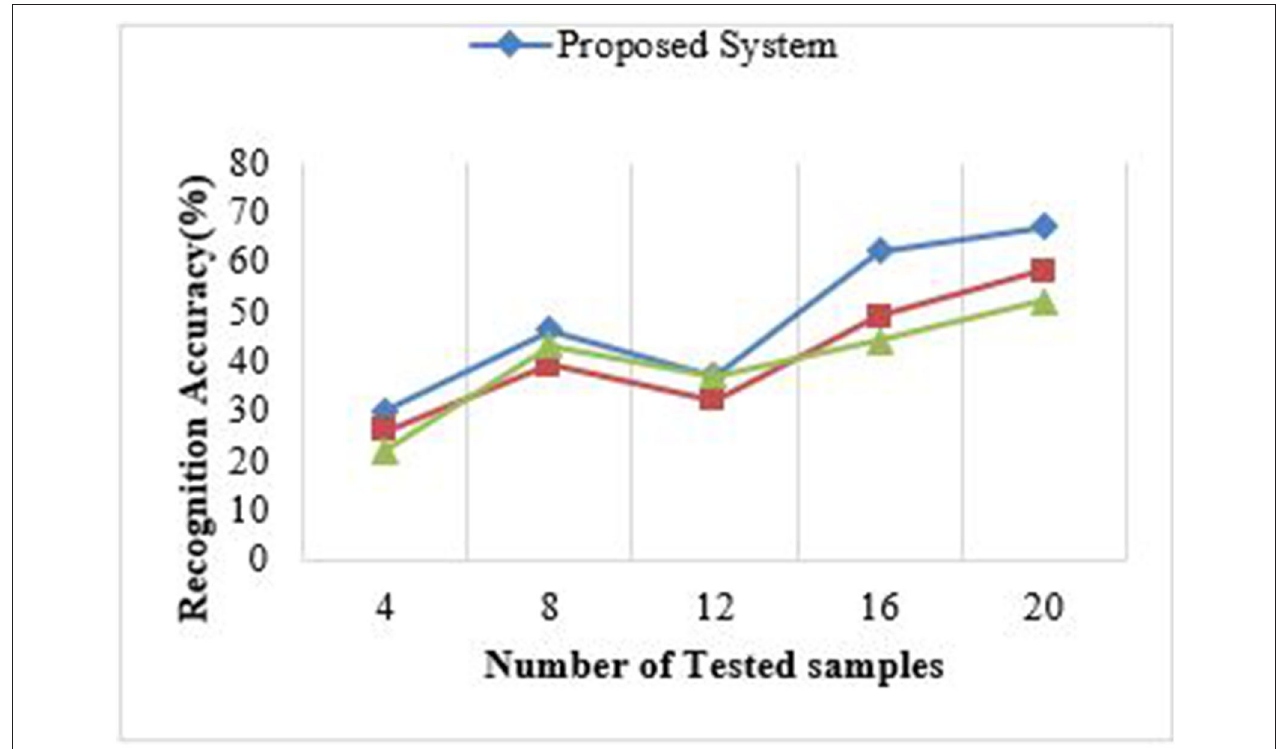
FIGURE 6 | Performance analysis using functional